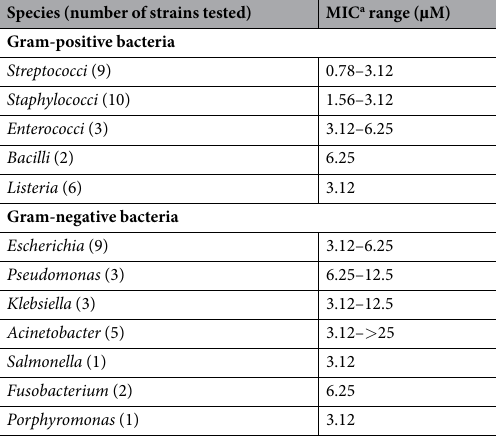
Table 1. MIC of C 14 KKc 12 K against a representative panel of bacteria. a MIC was determined by the microdilution method. Values represent the average of at least 2 independent experiments performed in duplicate.